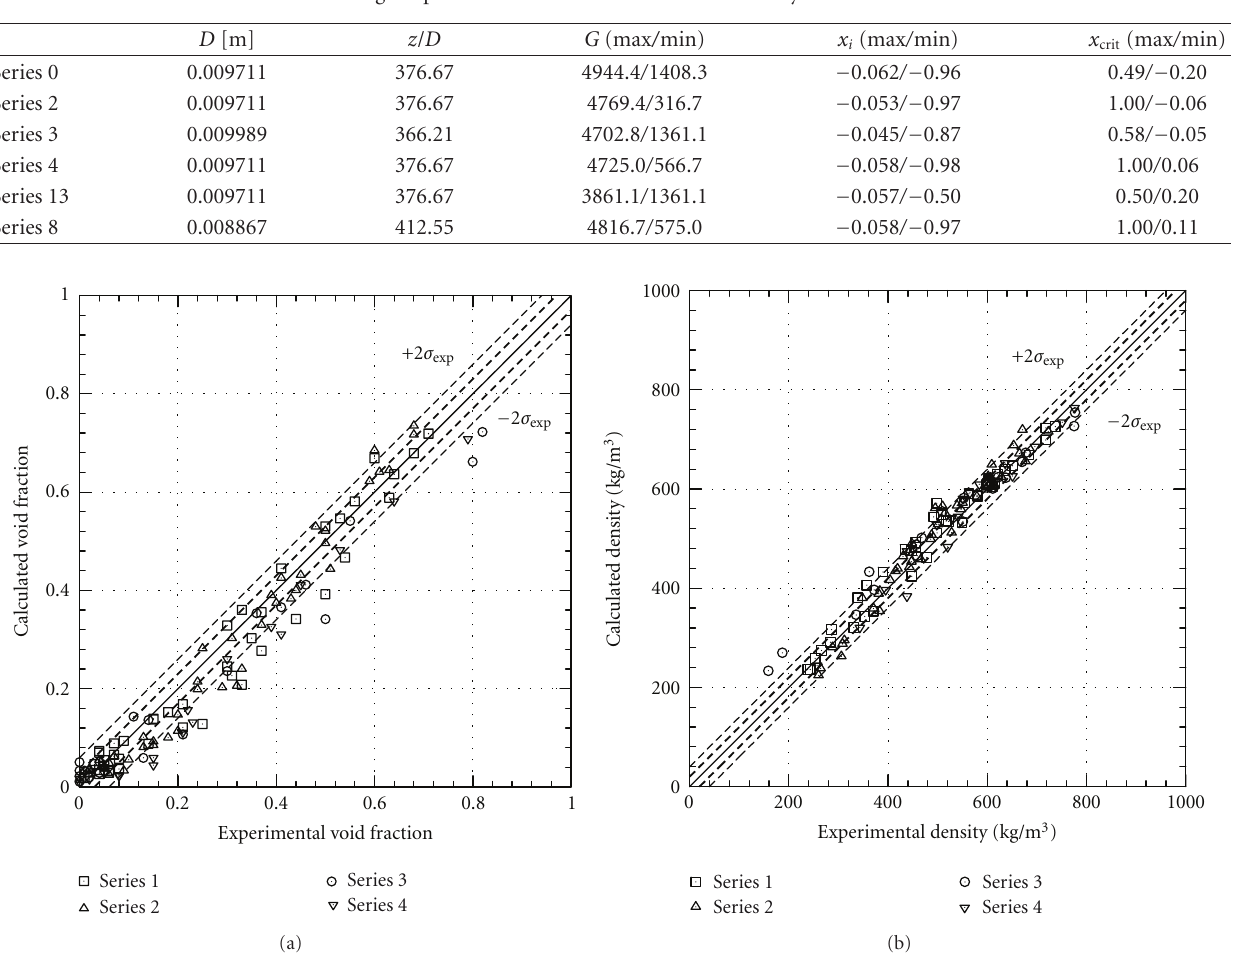
Table 2: Range of parameters for the Shah model covered by the NUPEC tests.